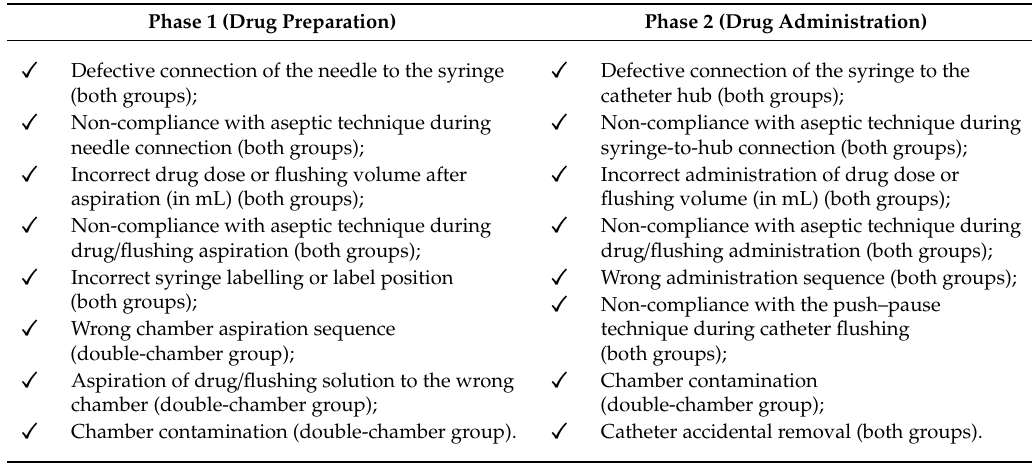
Table 5. Types of errors to be assessed during the